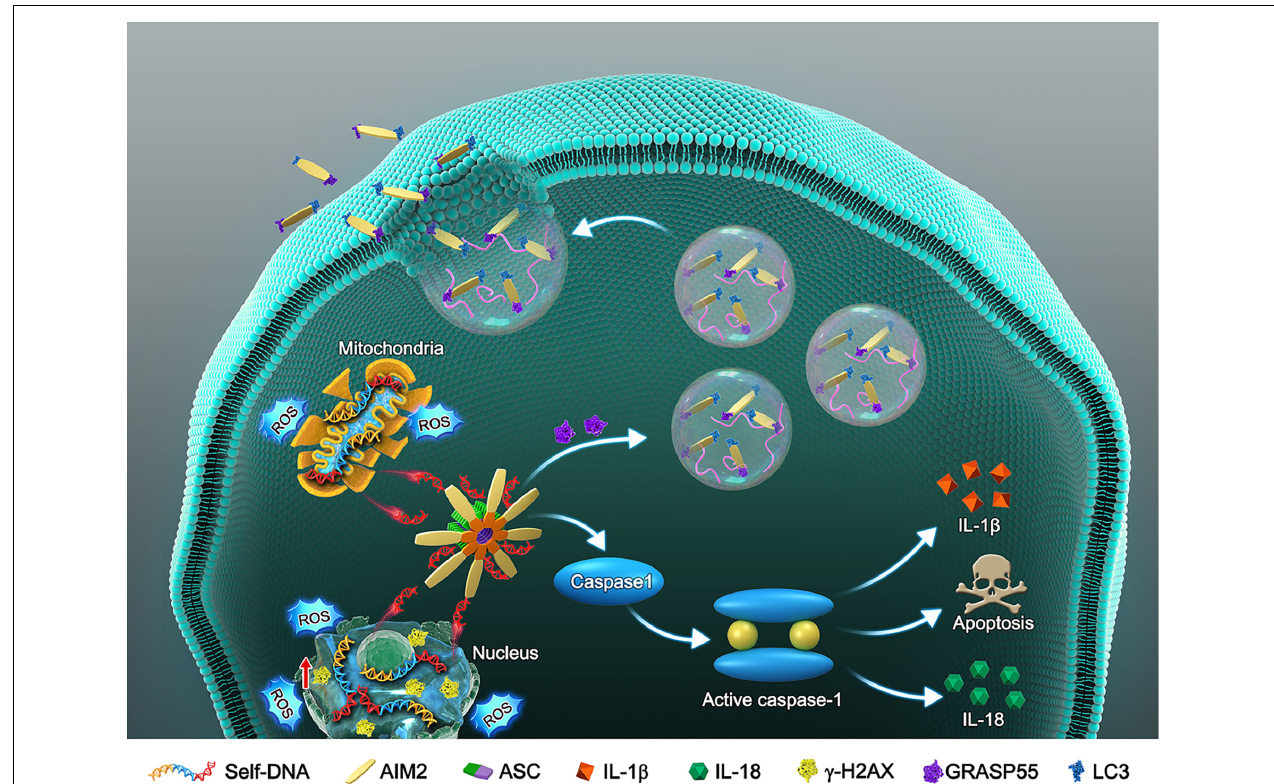
FIGURE 8 | Schematic model illustrates the autophagic secretory pathway of AIM2 in NP cells. Oxidative stress-induced DNA damage activates the AIM2 inflammasome and elicits the downstream inflammation cascade. During this process, autophagy activation ameliorates DNA damage via an unconventional secretion of AIM2. AIM2, Absent in melanoma 2; ASC, Apoptosis-associated speck-like protein containing a CARD; NP, Nucleus pulposus; ROS, Reactive oxygen species; IL-1 β , Interleukin-1b; IL-18, Interleukin 18; GRASP55, Golgi re-assembly and stacking protein